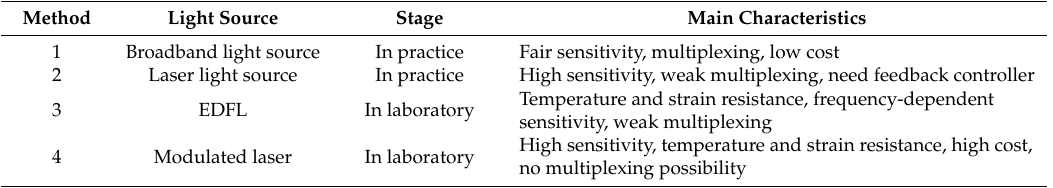
Table 2. The demodulation techniques and their characteristics.